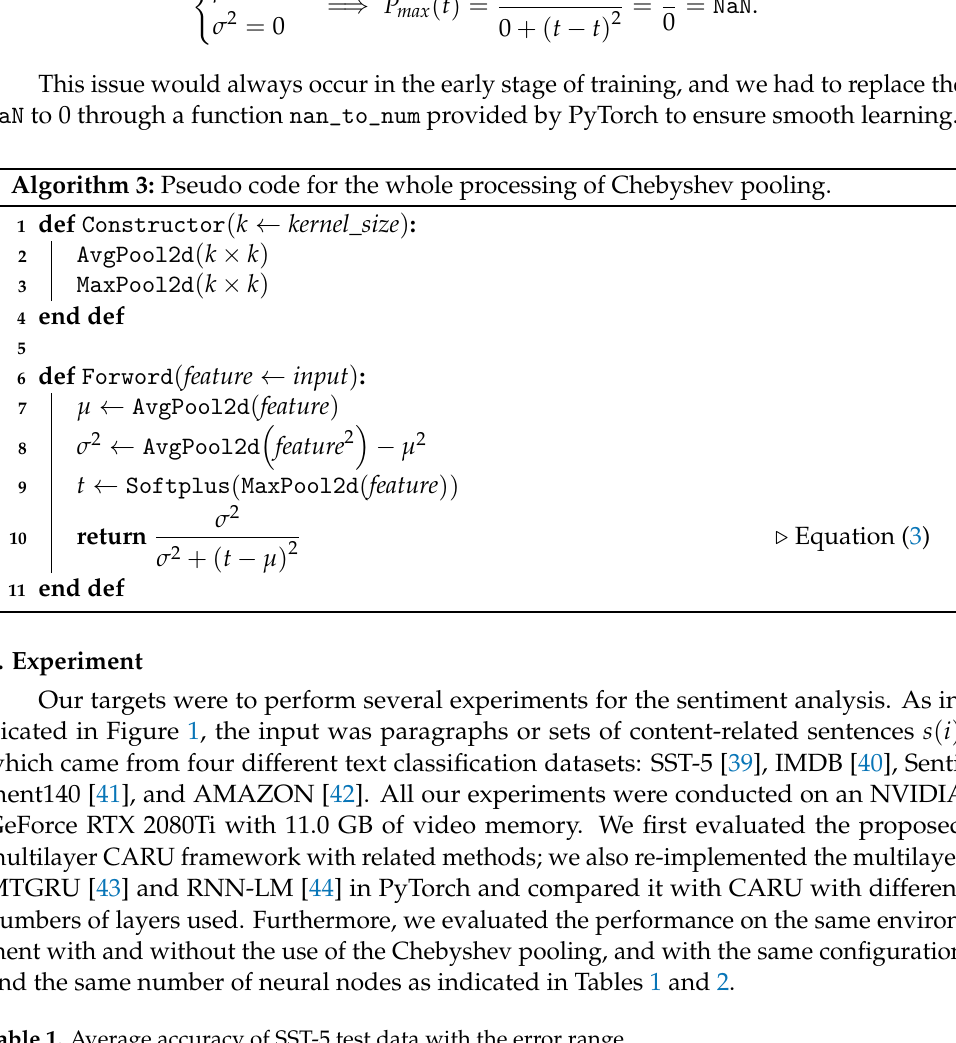
Table 1. Average accuracy of SST-5 test data with the error